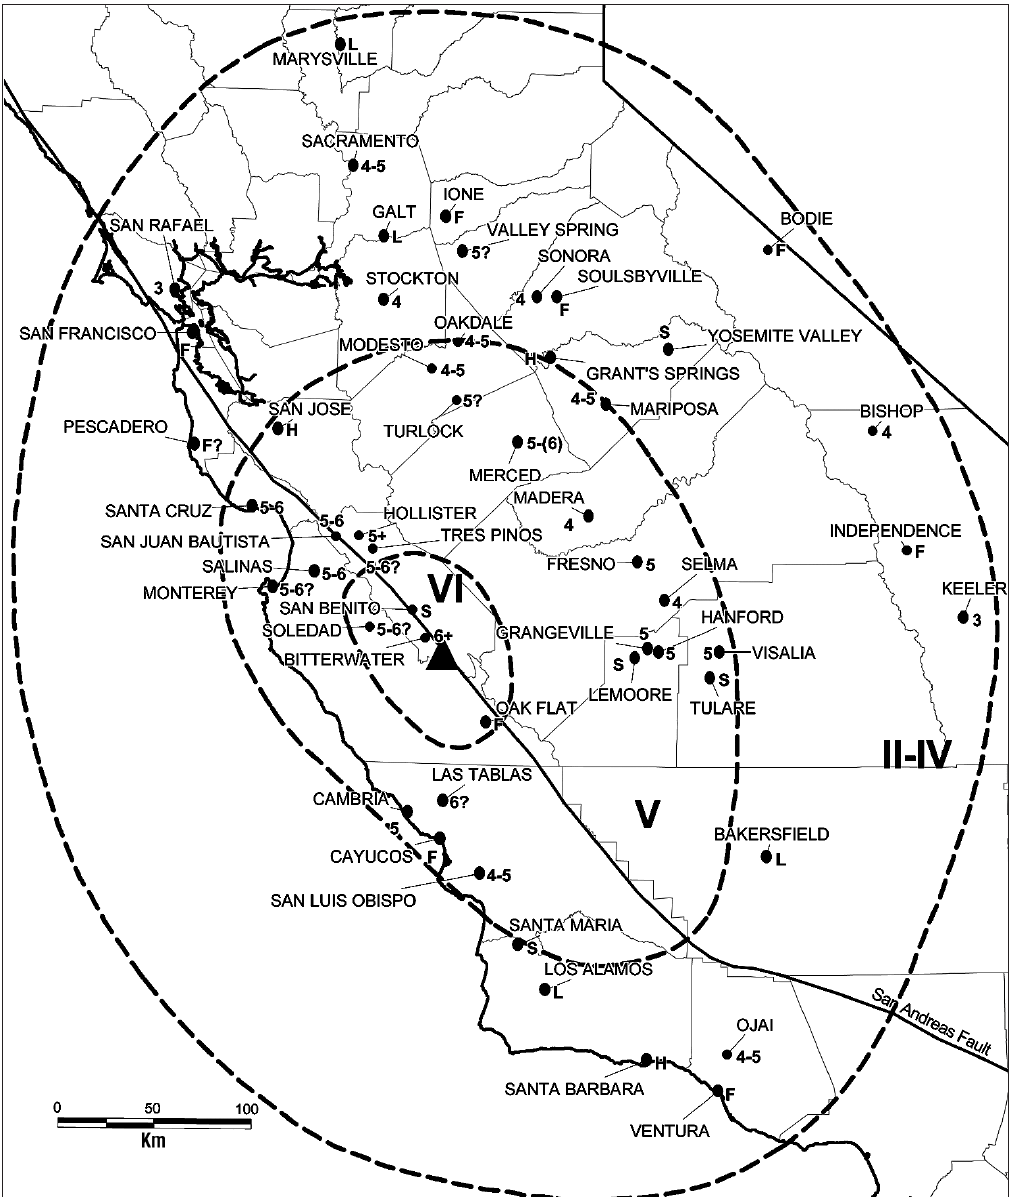
Fig. 5. 12 April 1885 isoseismal map. Numbers at towns are the MMI values based on the felt effects. When felt effects did not indicate a MMI value we use a letter: F, felt; S, severe; L, light; H, heavy. The triangle repre- sents the epicenter. The three dashed lines represent the areas of MMI greater than or equal to II-IV, V or VI used in the magnitude-area relations of Toppozada and Branum (2002) (modified from Toppozada et al .,